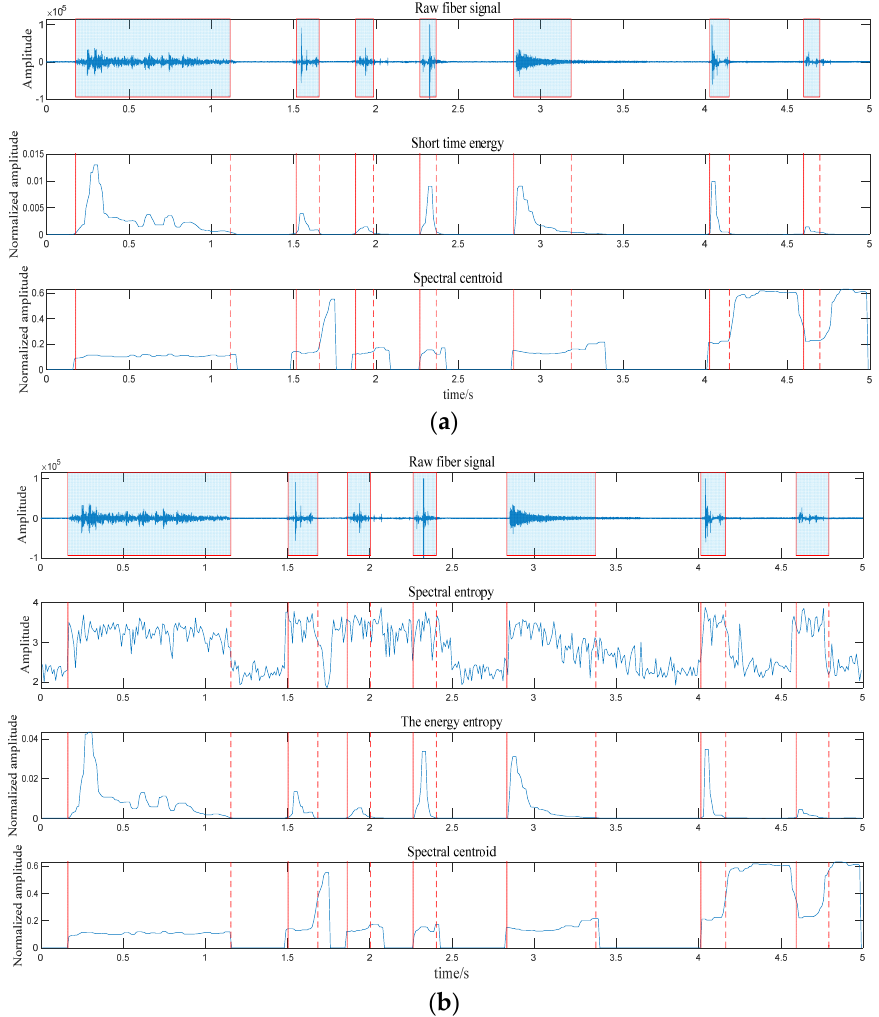
Figure 4. The comparison chart of different endpoint detection. ( a ) The endpoint detection method of ordinary spectral entropy and short − term energy; ( b ) the endpoint detection method based on the combination of spectral centroid and energy spectral entropy product.